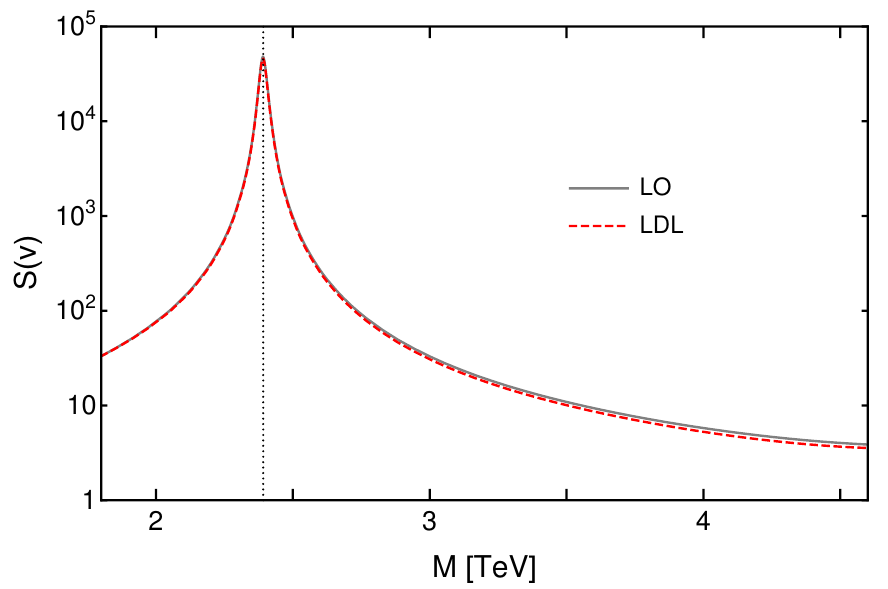
Figure 25 . Sommerfeld enhancement factor S ( v ) as a function of the wino mass M for the relative velocity v = 2 v 0 = 10 (cid:0) 3 : leading-order approximation (solid curve) and leading-double-logarithm approximation (dashed